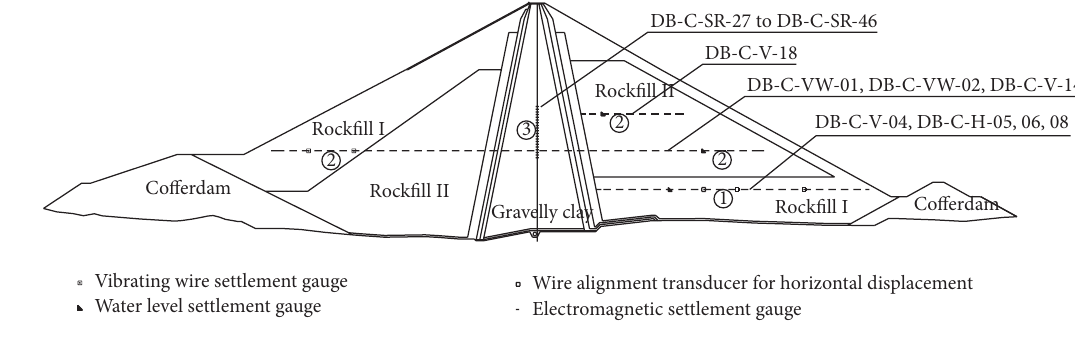
Figure 6: The measurement points used in the 1st back-analysis. Table 1: Stepwise displacement back-analyses.